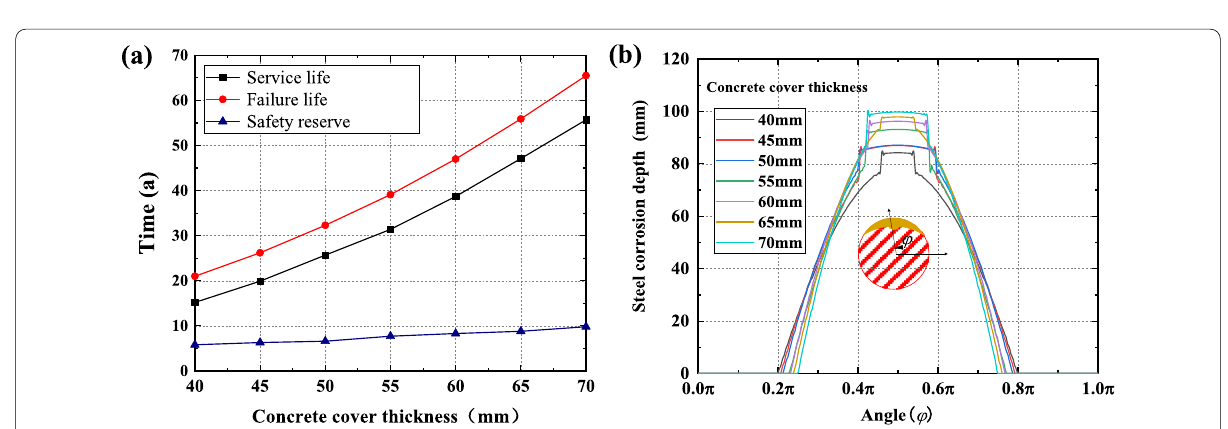
Fig. 7 Influence of concrete cover thickness on sand corrosion layer depth. a Service life. b Corrosion layer depth.